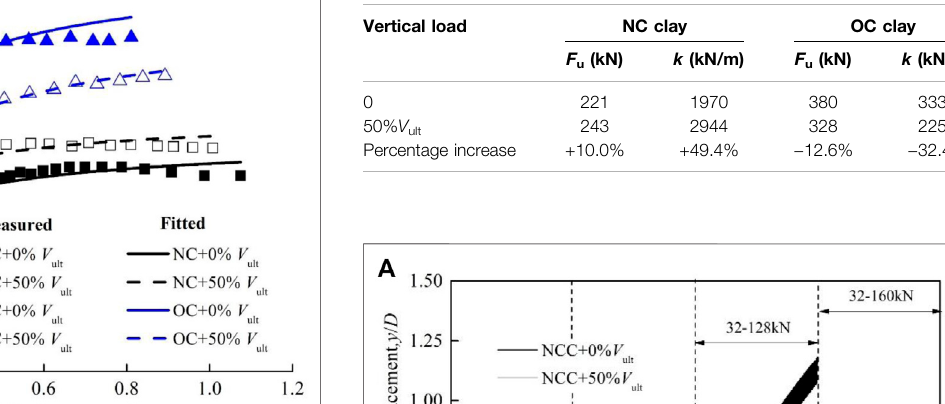
TABLE 3 | Summary of the ultimate lateral capacity and initial stiffness of the pile.